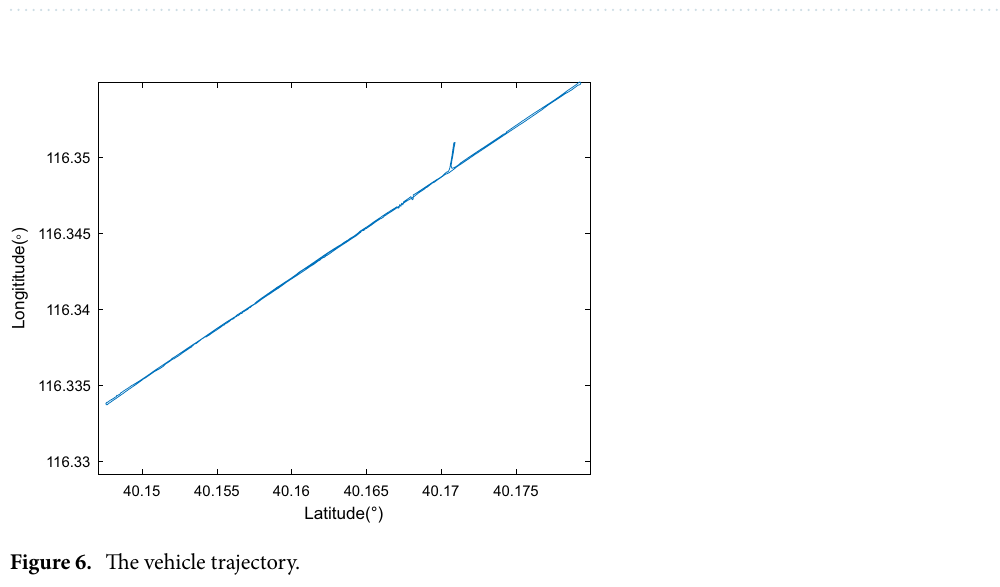
Figure 6. The vehicle